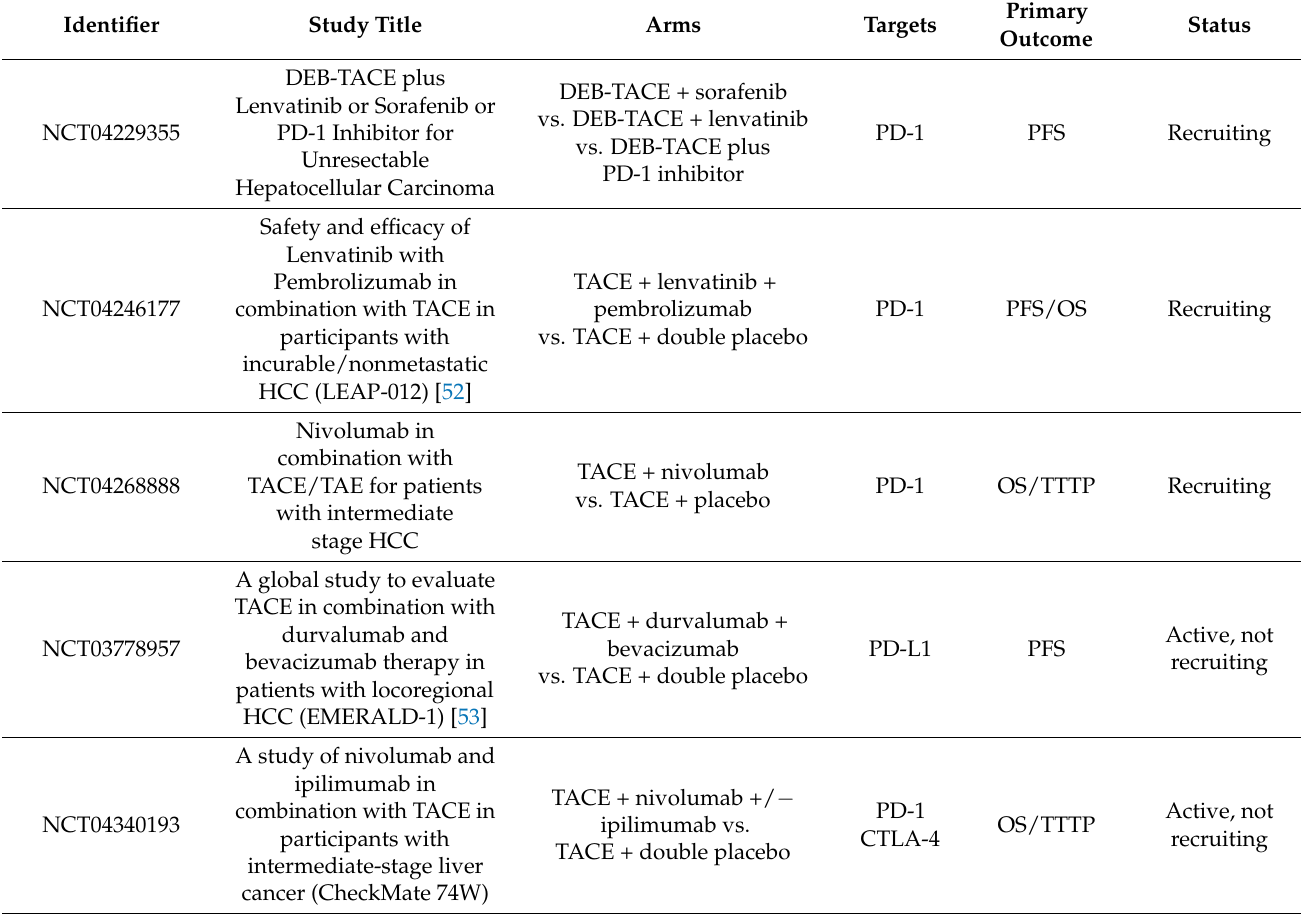
Table 5. Current phase III trials of immune checkpoint inhibitors in combination with trans- arterial